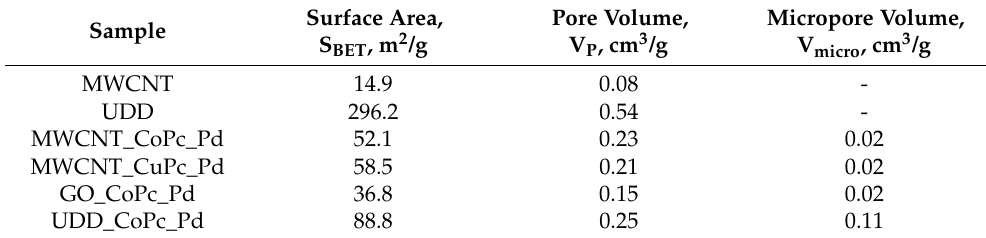
Figure 1. Low-temperature nitrogen adsorption-desorption isotherms for the synthesized catalysts. Table 1. The textural characteristics of the supports and catalysts.